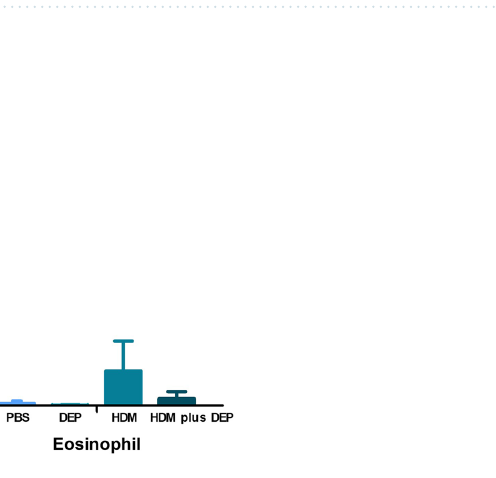
Figure 3. Eosinophil infiltration in the nasal mucosa. Co-exposure with HDM and DEP (group D) showing suppressed eosinophil infiltration in the nasal mucosa ( A ) Sirius red staining (× 400 magnification) of each group. Photographs are representative of nasal mucosa in each group. ( B ) Eosinophil count of the septal mucosa in each group. Data are expressed as mean ± standard error mean. * p < 0.05, ** p < 0.01.